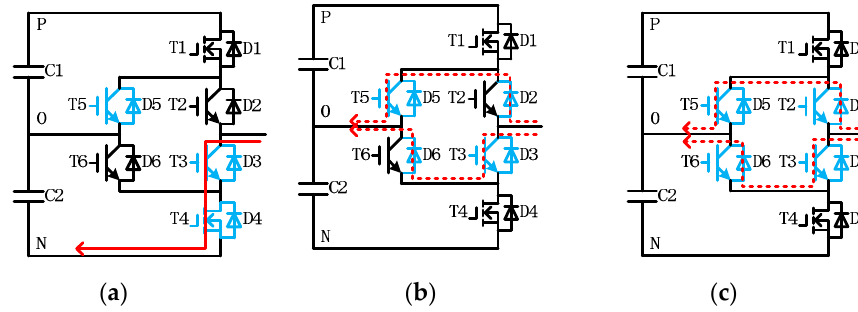
Figure 3. Commutation process between N and O: ( a ) N; ( b ) dead time; ( c ) O.